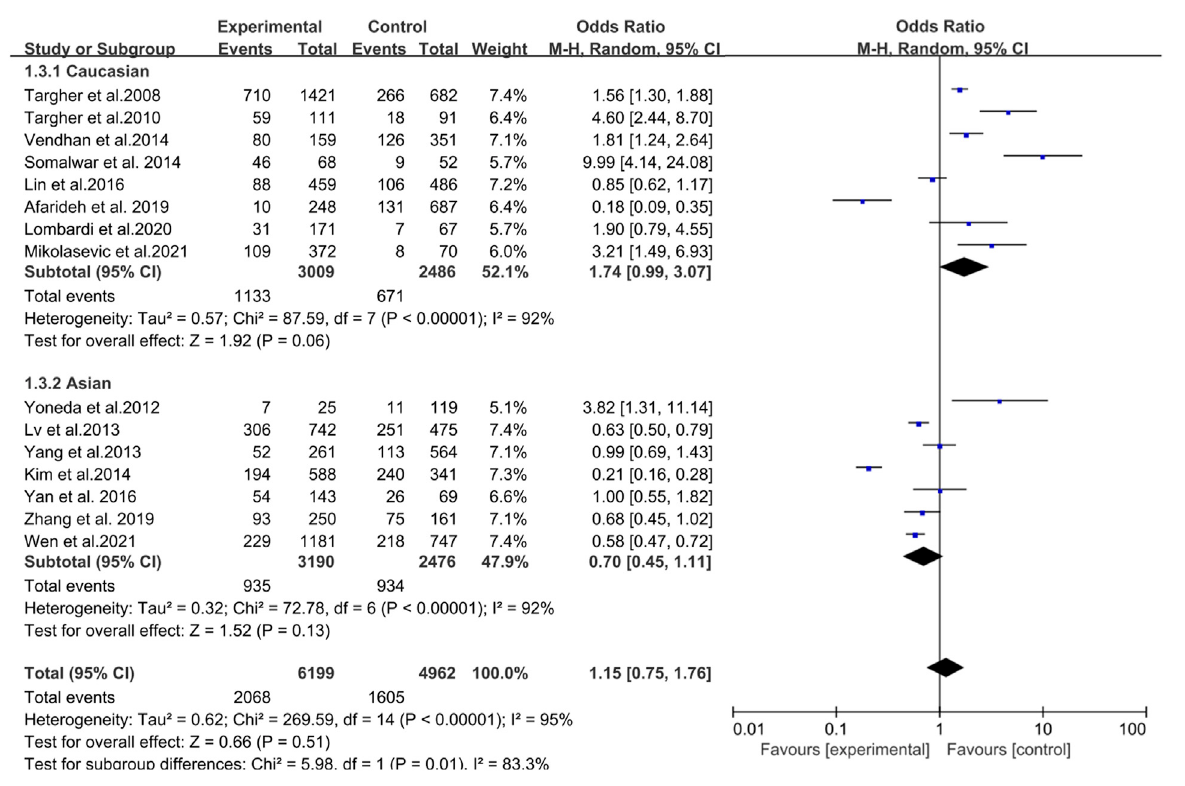
FIGURE 5 Meta-analysis of association between non-alcoholic fatty liver disease and the risk of diabetic retinopathy in diabetes mellitus based on the different races.